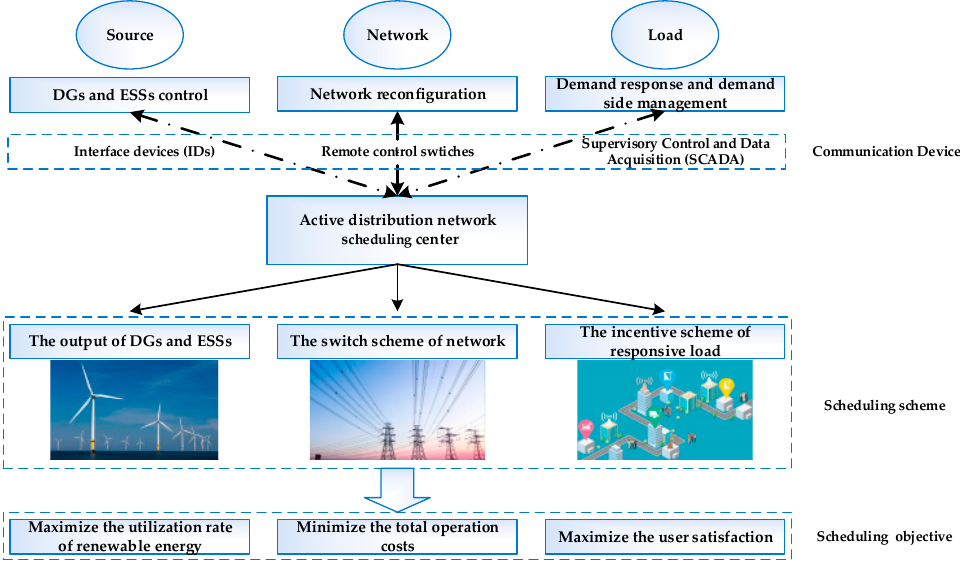
Figure 1. The scheduling strategy of source-network-load. DG: distributed generation; ESS: energy storage system.